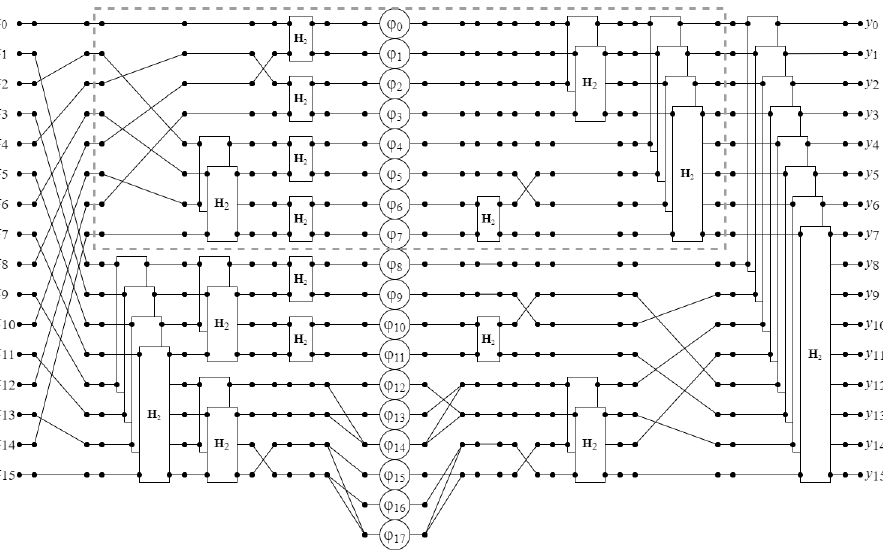
Figure 3. The data flow graph of the proposed algorithm for computation of 16-point